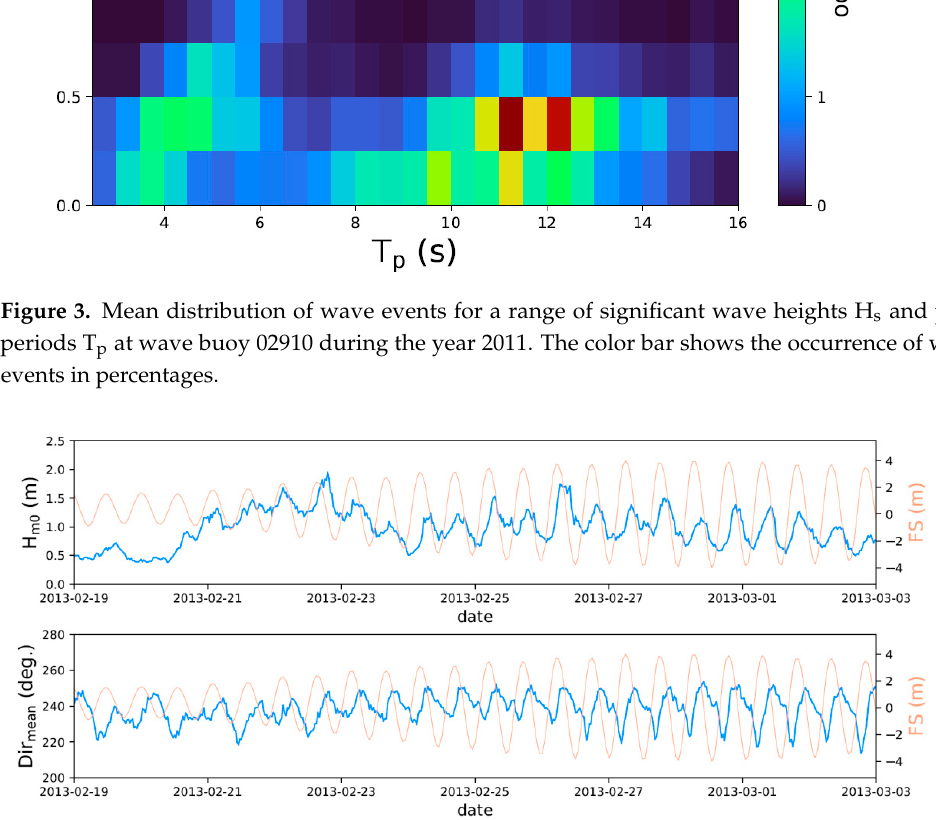
Figure 4. Time series of measured significant wave height (Hm0, blue line) and mean wave direction (Dirmean, blue line, anticlockwise convention from east) at wave buoy 02910 and free-surface elevation (FS with respect to mean water depth, red line) at the tidal gauge in the harbour of Roscoff–Bloscon during February and March 2013.